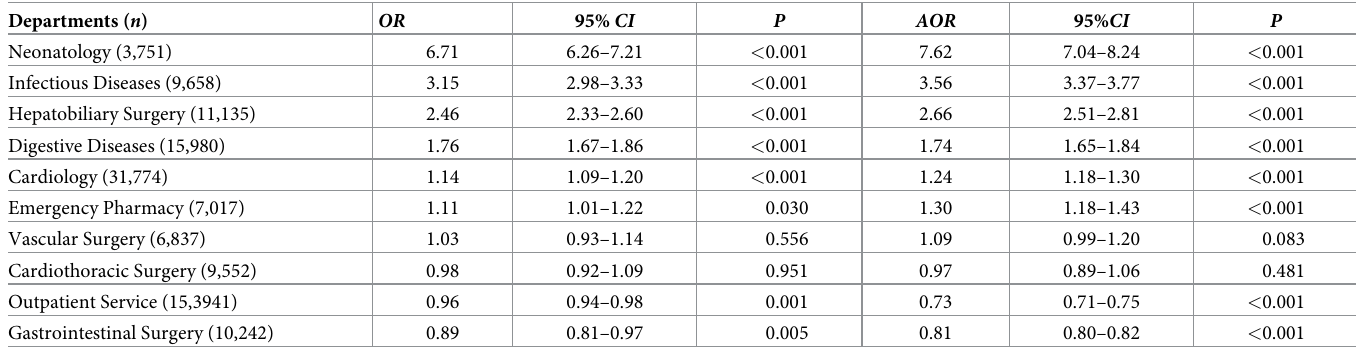
Table 7. Logistic regression analysis of the OR and the AOR of icterus in the top ten clinical departments (n = 259,887). Departments ( n ) Infectious Diseases